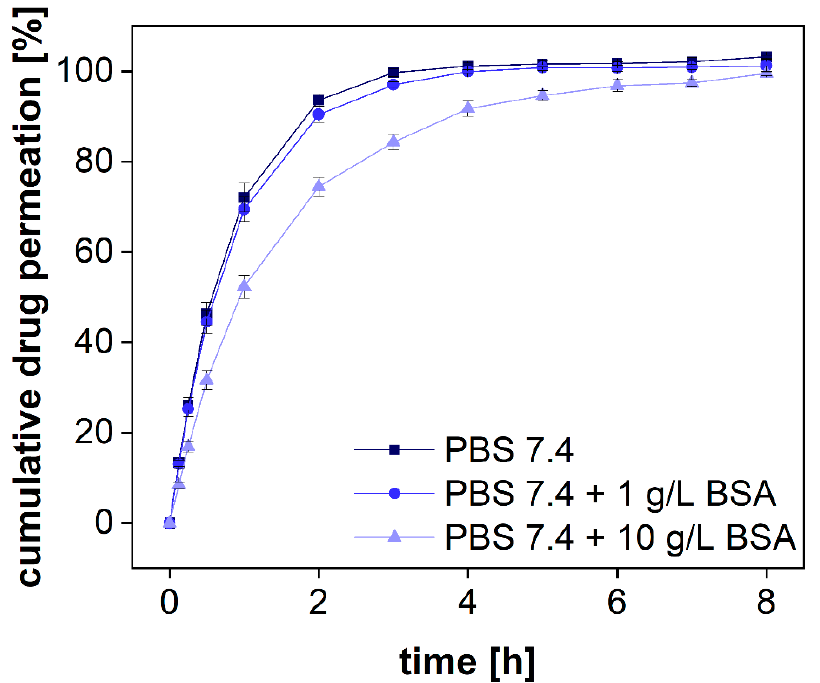
Figure 7. Cumulative permeation of diclofenac sodium with different amounts of BSA in PBS 7.4. A regenerated cellulose membrane (MWCO 50 kDa) was used to separate the two compartments. The experiment was conducted at 37 °C at 100 rpm ( n = 6). Mean values ± SD are shown. Table 3. Calculated AUC of diclofenac sodium permeation in PBS 7.4 with different BSA amounts ( n =